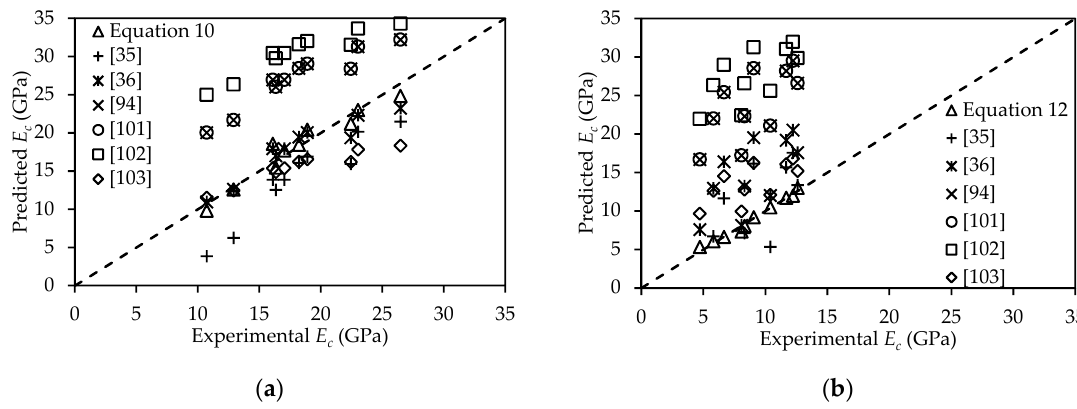
Figure 14. Predicted versus experimental modulus of elasticity for mixtures with slag:fly ash of: ( a ) 3:1; ( b ) 1:1.